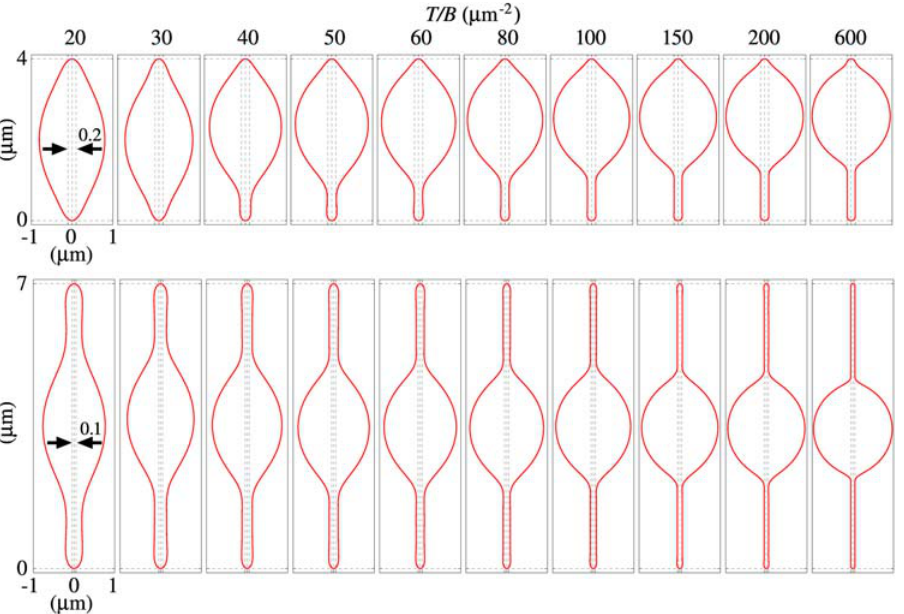
Figure 3. Stable (top row) and locally stable (bottom row) axisymmetric surfaces given by numerical minimization of W. The top row shows a one-parameter scan through a range of fixed T/B values, with the constraints t i =0, V net =4 p /3=4.19 m m 3 , L =4 m m and r =0.1 m m. The values of T/B are, from left to right, 20, 30, 40, 50, 60, 80, 100, 150, 200, and 600 m m 2 2 . These T/B values are within the expected physical range, since they are at least an order of magnitude smaller than that required for membrane rupture, assuming that B , 4 6 10 2 19 J [26] and the membrane ruptures at T , 2 mN/m [20]. The bottom row shows a one-parameter scan through the same range of T/B values as above, with the constraints t i =0, V net =4 p / 3=4.19 m m 3 , L =7 m m, and r =0.05 m m. Top row, left to right: A =14.44, 14.06, 14.07, 13.96, 13.88, 13.81, 13.79,13.76, 13.75, and 13.74 m m 2 ; P/B =33.15, 51.80, 70.47, 89.28, 108.15, 146.07, 183.98, 278.71, 373.49, and 1131.32 m m 2 3 . Bottom row, left to right: A =17.33, 16.43, 16.04, 15.70, 15.45, 15.09, 14.84, 14.46, 14.23, and 14.11 m m 2 ; P/B =34.37, 53.10, 71.64, 90.51, 109.48, 147.62, 185.96, 282.39, 379.30, and 1158.77 m m 2 3 . The two- tether surfaces are calculated without imposing mirror symmetry about the plane bisecting the n-MTB. done by the n-MTB (the magnitude of the axial force exerted at two points on the NE (F MT ) by a n-MTB of given length (L)). This yields the final form of the equation (Table 1, Eq. [4]) in which the